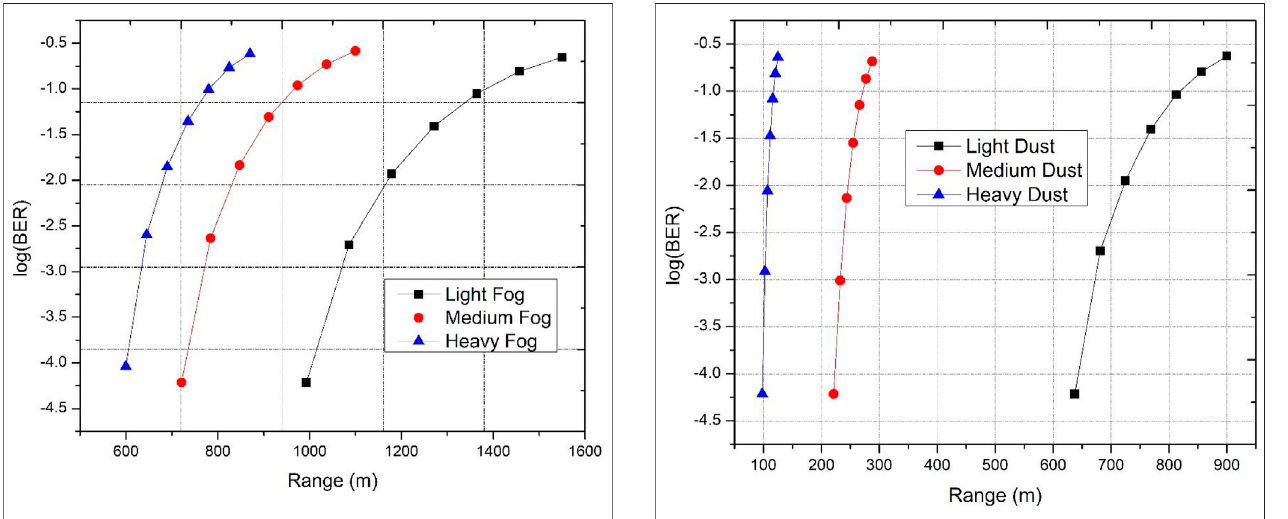
FIGURE 8 | log(BER) vs. range under different fog conditions for OFDM/ SAC-OCDMA-FSO.